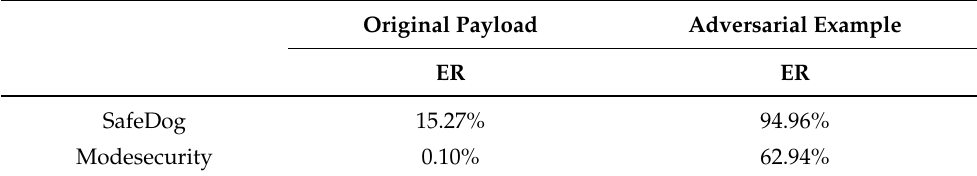
Table 7. The performances of WAF applications.